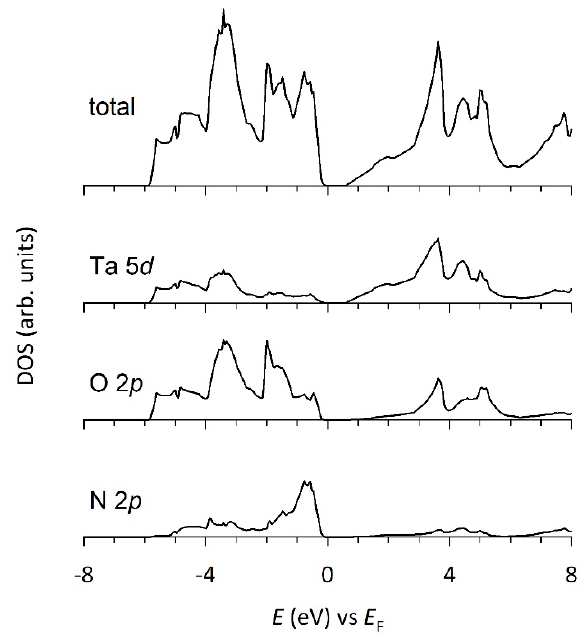
Figure 2. Valence band density of states (DOS) structures for BaTaO 2 N, SrTaO 2 N, CaTaO 2 N, KTaO 3 , and TaO 2 F as calculated using the CAmbridge Serial Total Energy Package (CASTEP) code.